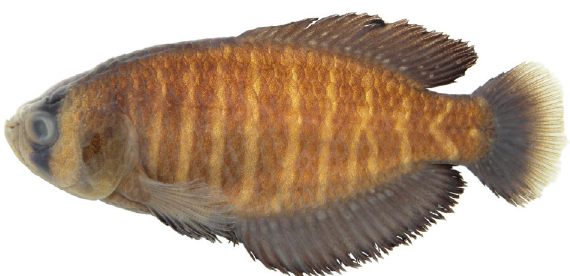
Figure 1. Austrolebias queguay sp. n., ZVC-P 13576, 39.4 mm SL, holotype, male, Estancia La Beba (32°11’08”S, 57°26’08”W), wetlands of Río Queguay Grande, Paysandú De - partment,